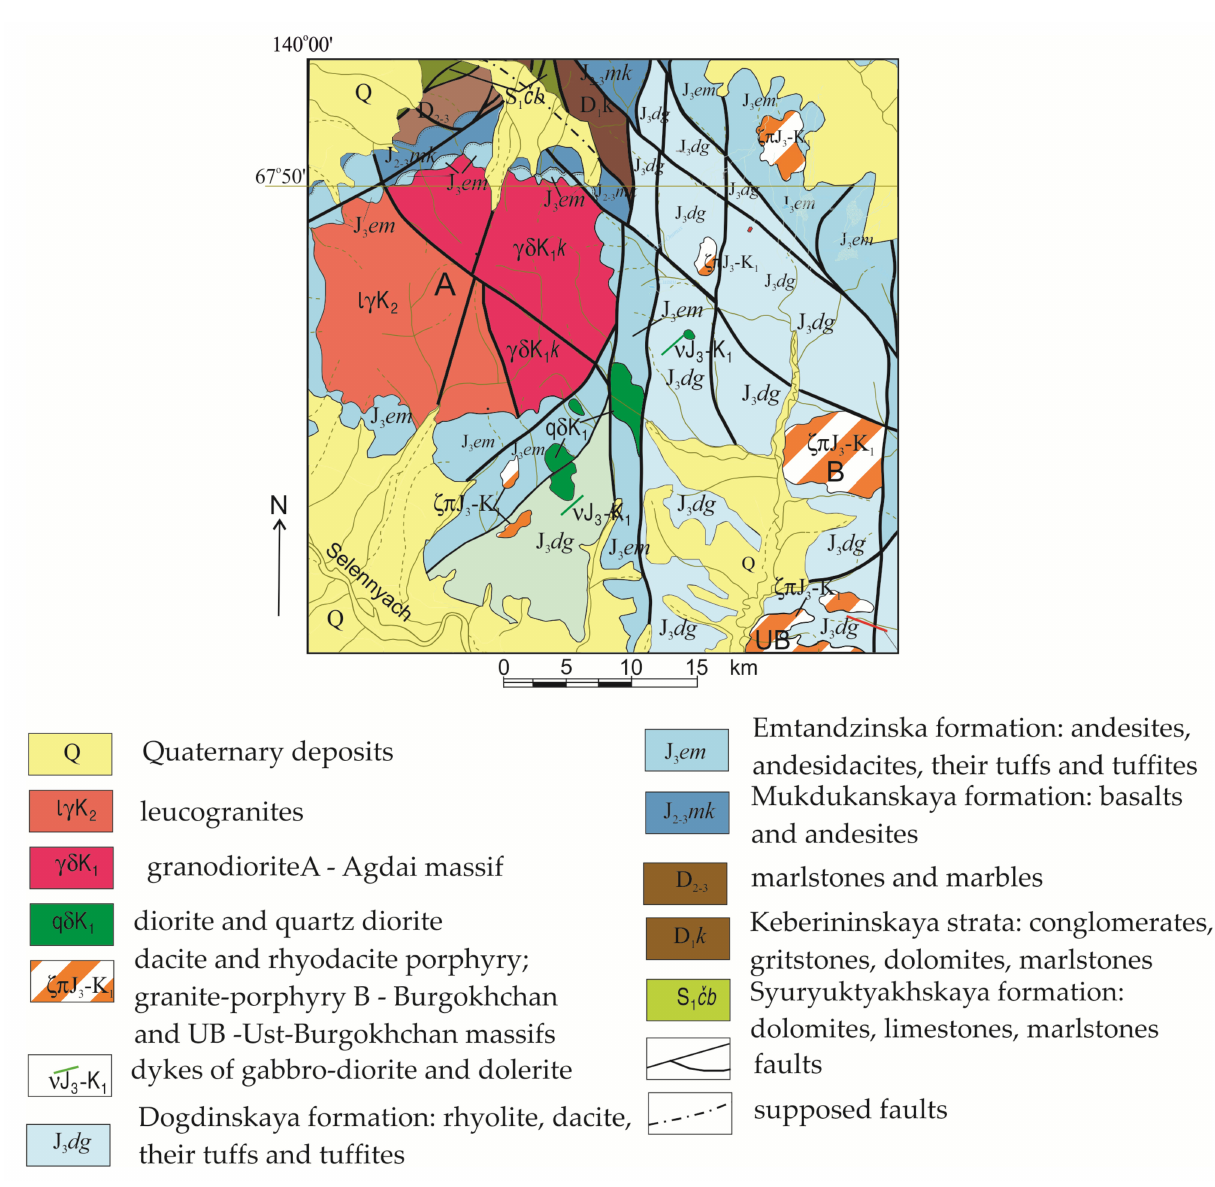
Figure 3. Geological map of the Agdaisky